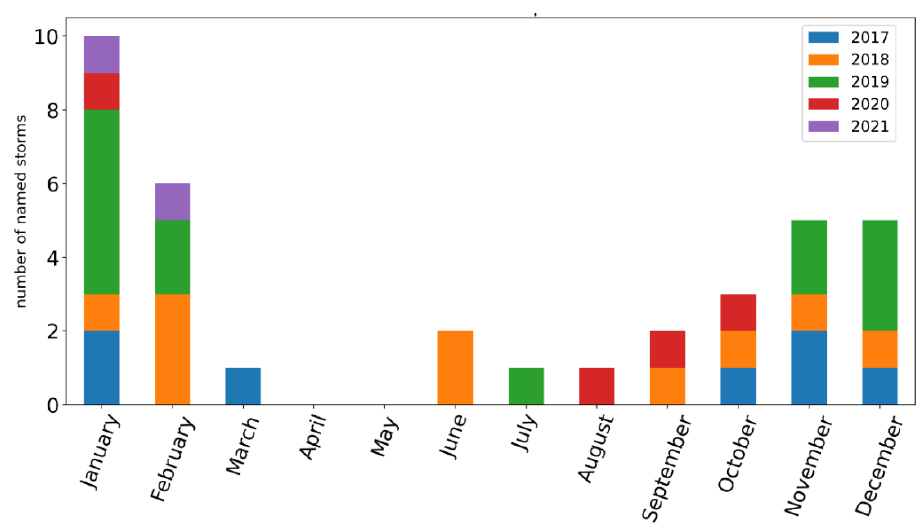
Figure 1. Number of named storms in Greece per month between January 2017 and September 2021. Color bars denote the year of occurrence of each named storm.